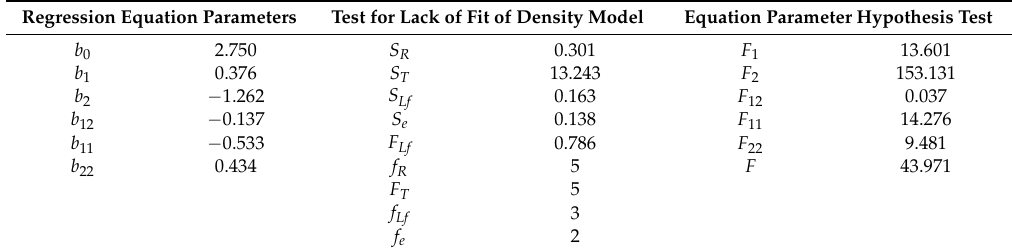
Table 4. Equation coefficients and statistical parameters of canopy density model.